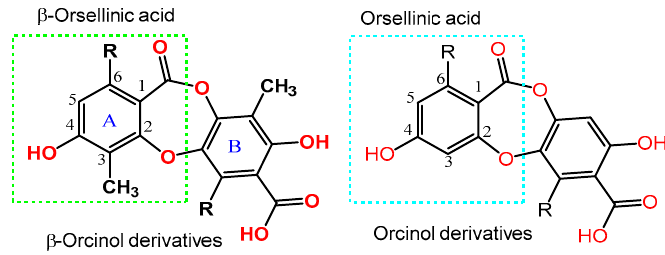
Figure 1. Examples of selective CB2R agonists.